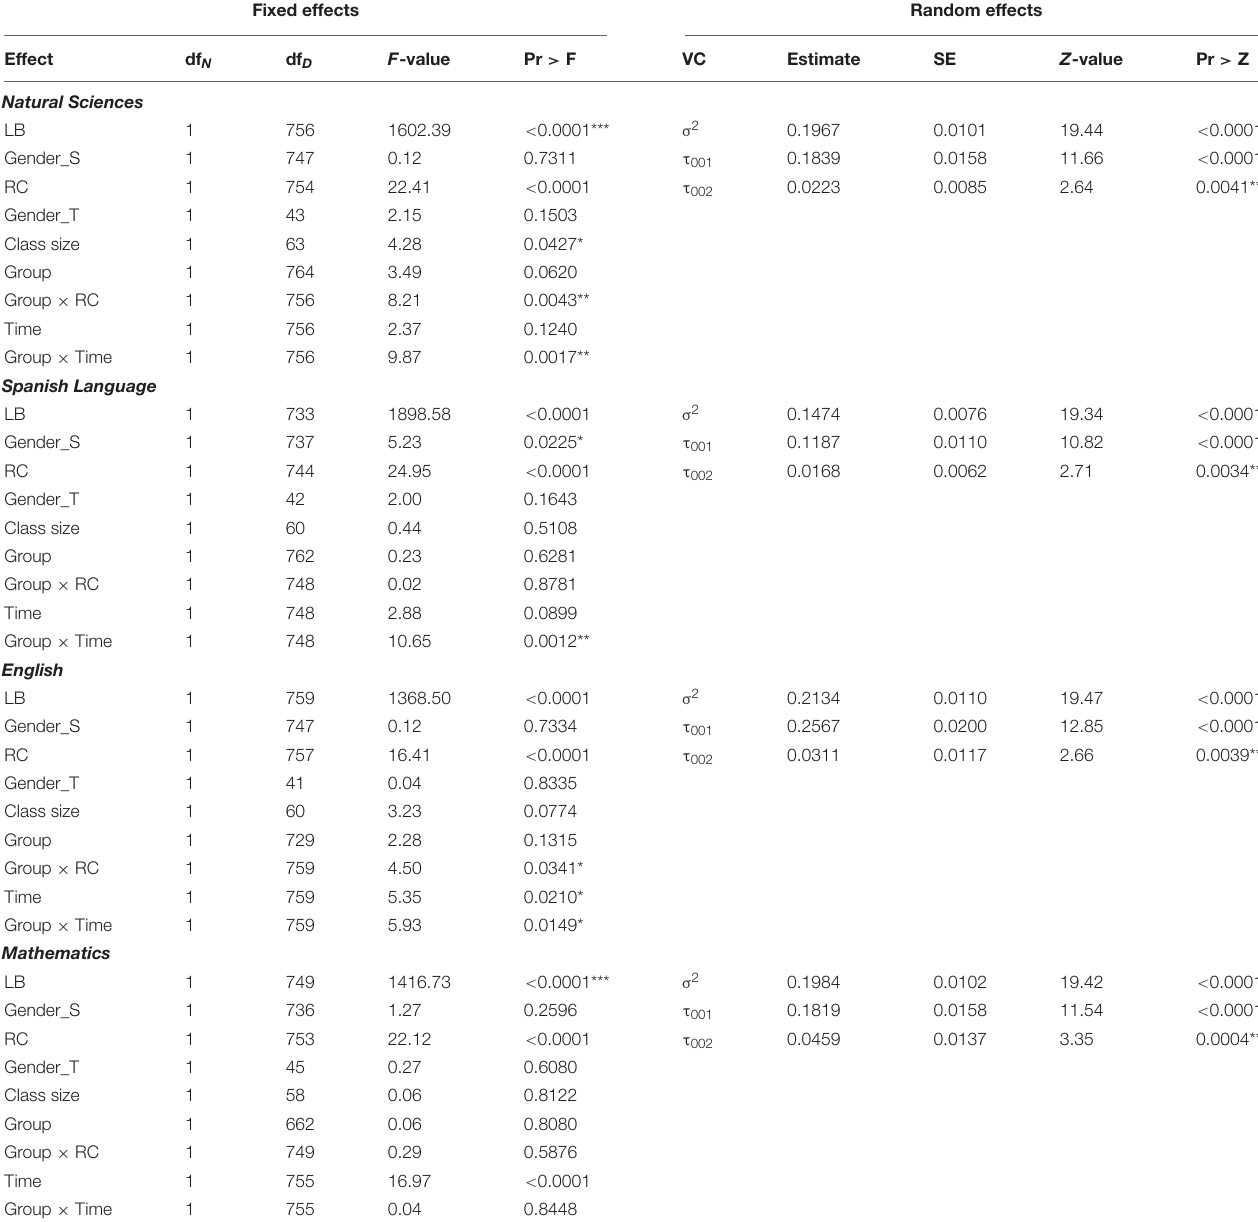
TABLE 3 | Results of mixed-effects regression analysis of each of the four dependent